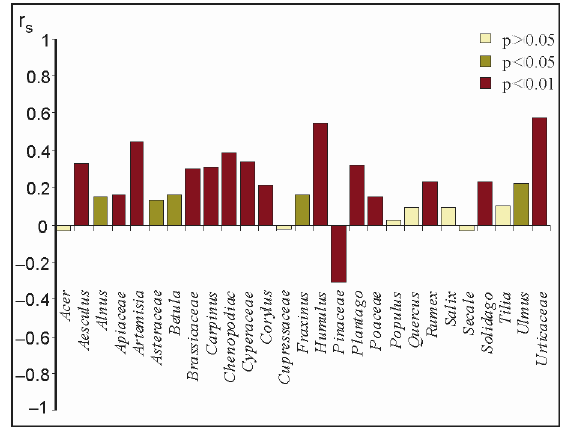
Fig. 3. Correlation coefficients (r s ) of plants pollen concentra- tion of various genera and families during the pollen season and relative air humidity in 2004 –